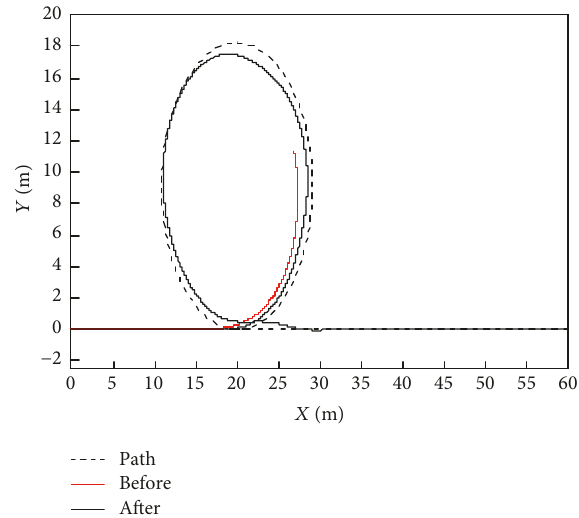
Figure 8: Simulation result of improved prediction point search algorithm.